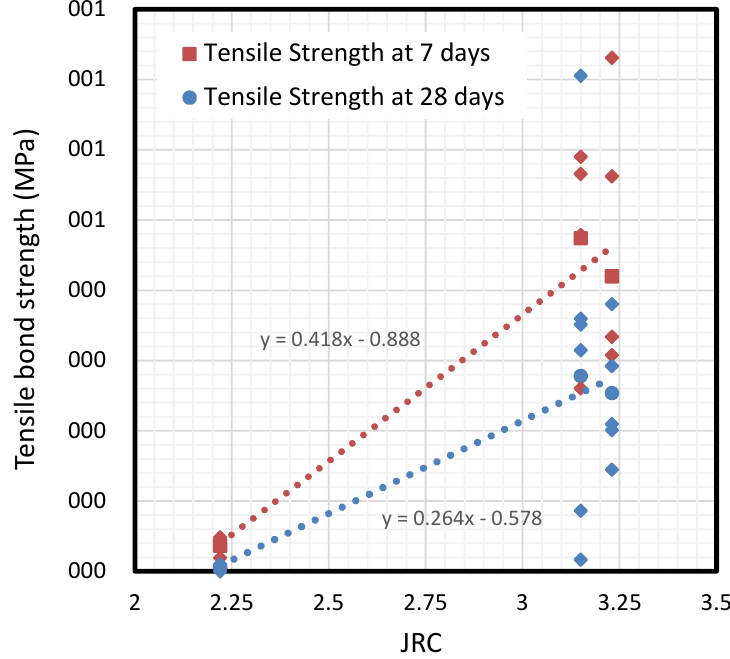
Figure 10. Tensile bond strengths depending on the roughness factor JRC.